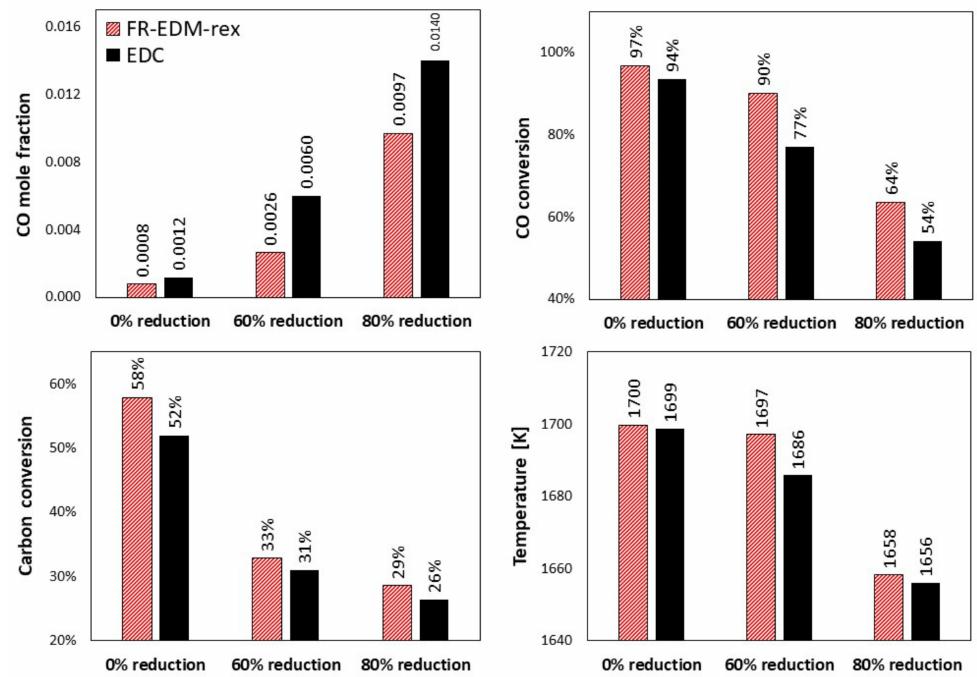
Figure 12. Comparison between FR-EDM-rex and EDC model; reflux chamber off-gas outlet temper- ature, CO mole fraction, CO conversion, and carbon conversion for different oxygen reduction